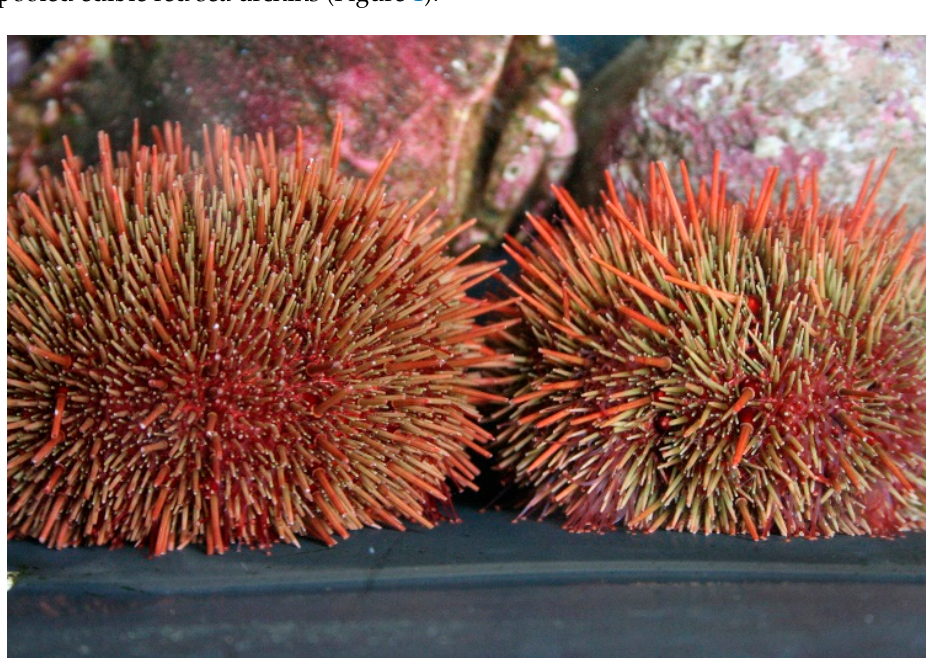
Figure 1. Juvenile edible red sea urchins ( Loxechinus albus ).